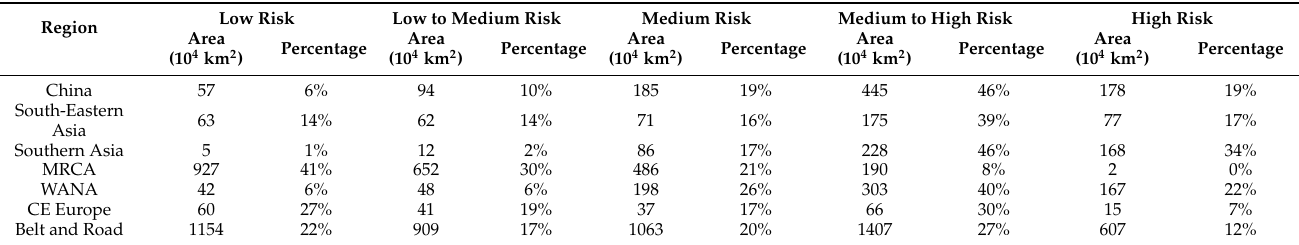
Table 6. “Belt and Road” regional water hazard risk statistics table.